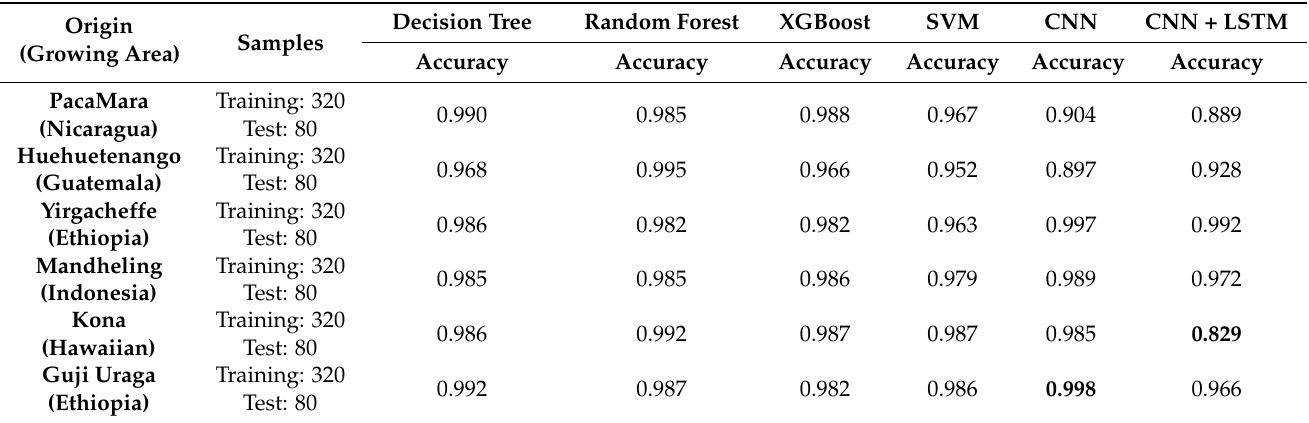
Table 4. Classifier performance results in scenario using 2-class-predictions (experiment 2).